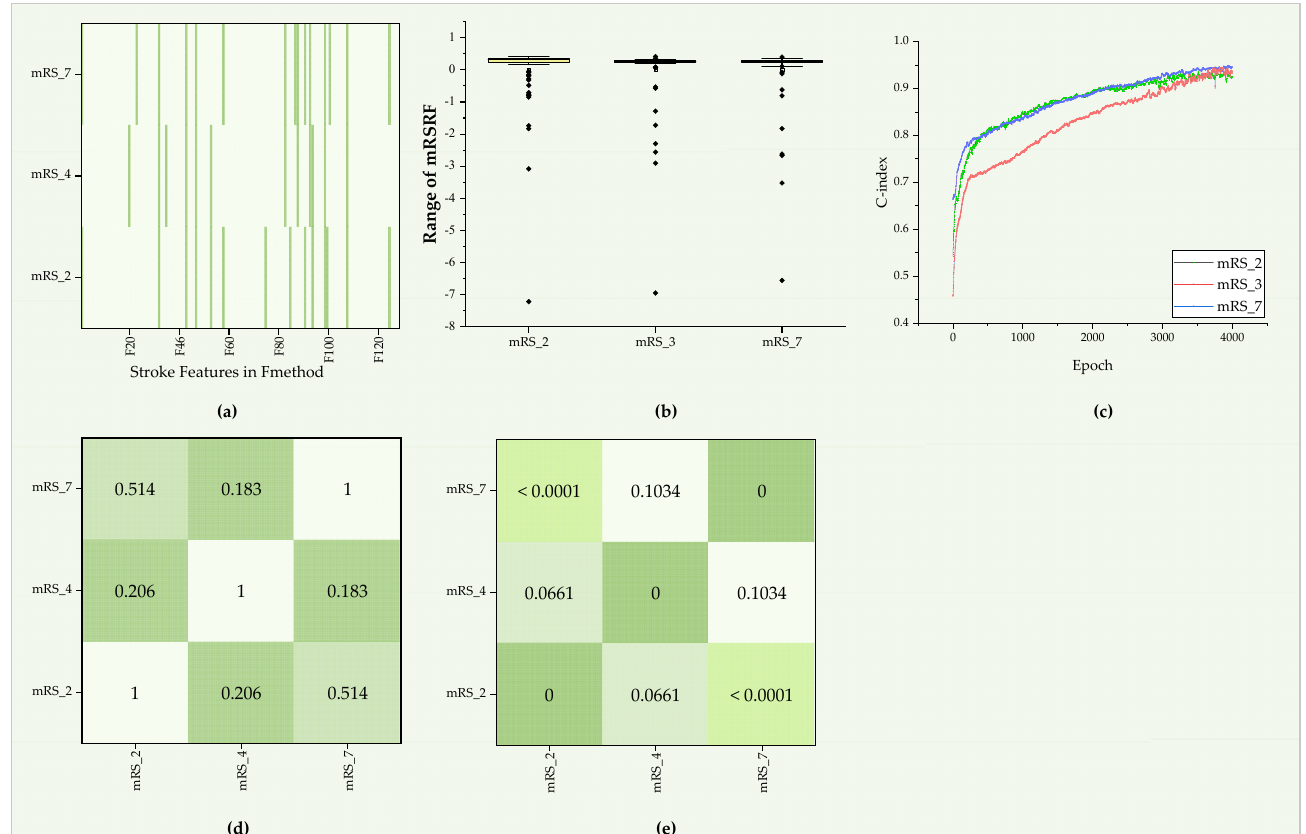
Figure 6. Selected mRSRF and statistics in mRS_2, mRS_4, and mRS_7. ( a ) mRSRF in three situations, and green color represents selected items from 128 outstanding features in F method . ( b ) Box plot among the three groups of mRSRF. ( c ) C ‐ index of the Deepsurv model in training. ( d , e ) Pearson correlation coefficients and p ‐ values among the three groups of mRSRF.